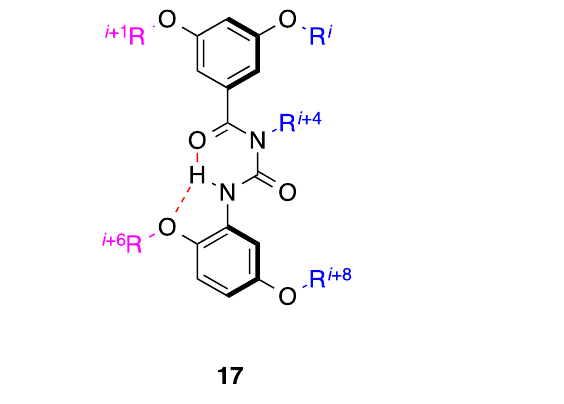
Figure 5. Two-faced bis-benzamide helix mimetics. Dashed lines represent hydrogen bonds.